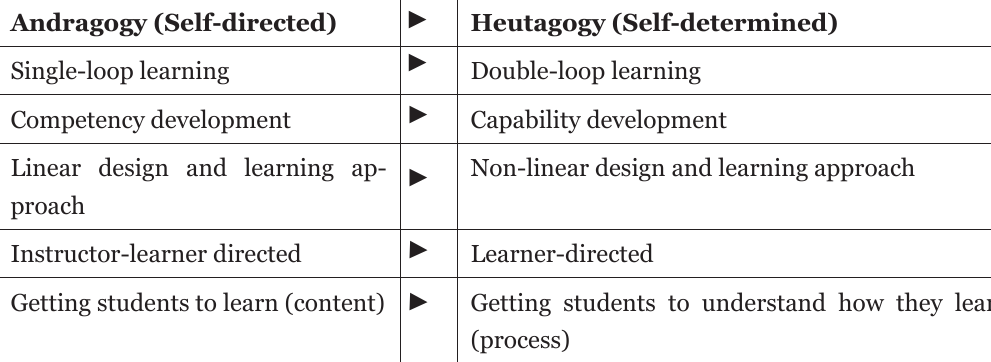
Non-linear design and learning approach